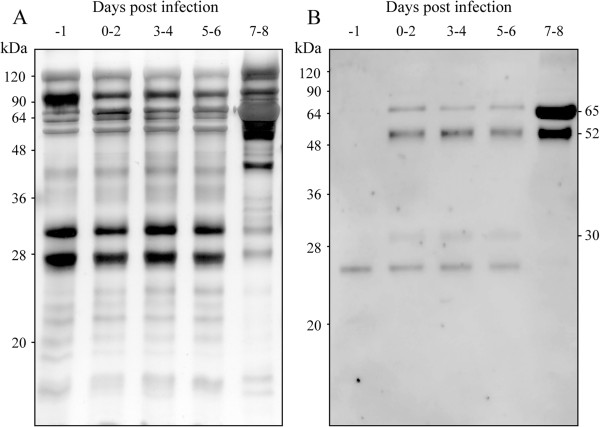
SDS-PAGE and immunoblotting of hamster urine protein during Leptospira infection. (A) Compositions of hamster urinary proteins were compared according to infection periods. Hamster urine was collected and prepared for SDS-PAGE. The urine of three hamsters was mixed for each infection period. The protein content of each sample was 5 μg. After separation with SDS-PAGE, the gel was stained by silver staining. (B) The anti-L. interrogans pAb recognized leptospiral proteins in infected-hamster urine by immunoblotting. These experiments were repeated three times, and the representative data are shown in this figure.